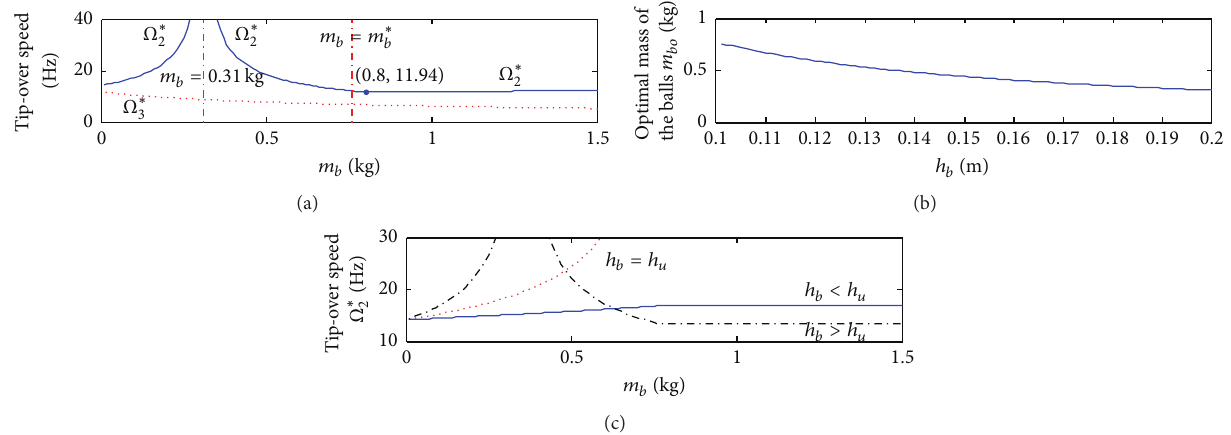
Figure 10: Variations of Ω ∗ 2 and Ω ∗ 3 along with increase of 𝑚 𝑏 when ℎ 𝑏 = 0.2 m (a). Variations of the optimal mass of the balls 𝑚 𝑏𝑜 with ℎ 𝑏 (b). Changes of Ω ∗ 2 along with increase of 𝑚 𝑏 when ℎ 𝑏 = 0.2 m, ℎ 𝑏 = ℎ 𝑢 = 0.1 m, and ℎ 𝑏 = 0.05 m. Other parameter values are 𝑚 𝑢 = 2 kg, = 0.1 m , ℎ = 0.03 m, and 𝐹 = 100 ℎ 𝑢 𝑐 pre